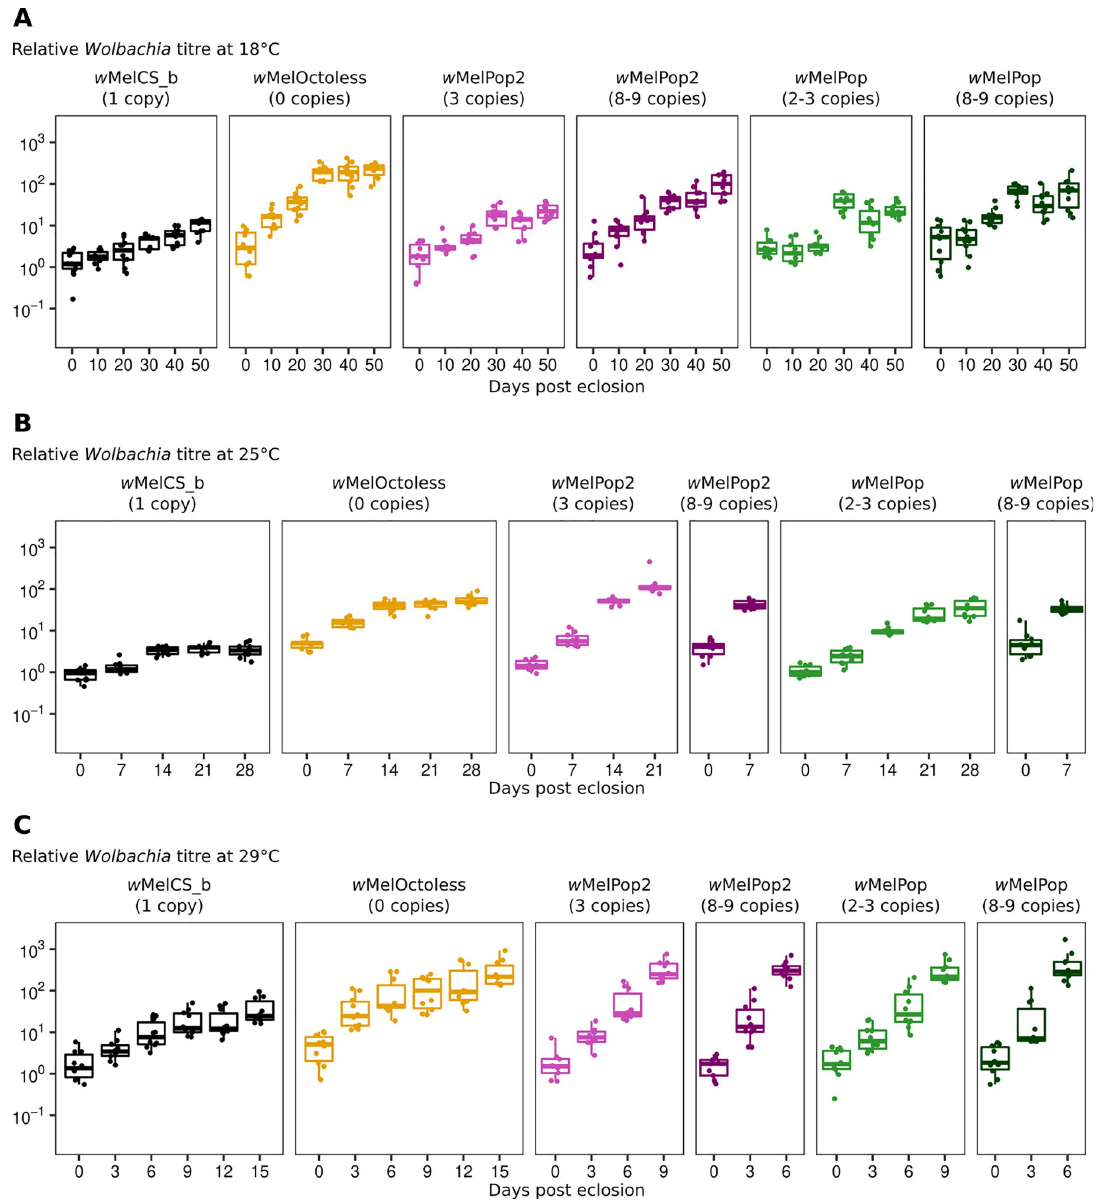
Fig 3. The amplification or deletion of Octomom increase Wolbachia proliferation rate in adults. Time-course of relative Wolbachia titres in adults at 18˚C (A), 25˚C (B) and 29˚C (C) with different Wolbachia variants. D . melanogaster males used in these experiments developed at 25˚C, were collected on the day of adult eclosion and aged at the given temperatures (18˚C, 25˚C or 29˚C). Ten males were collected at each time-point for Wolbachia titre measurement using qPCR. Wolbachia titres were normalized to that of 0–1 day-old w MelCS_b-infected males. A replicate of the experiment is shown in S10 Fig. Exponential models were used to estimate Wolbachia doubling time, using both full replicates, and a summary of the results is given in Table 1. Each dot represents the relative Wolbachia titre of a single